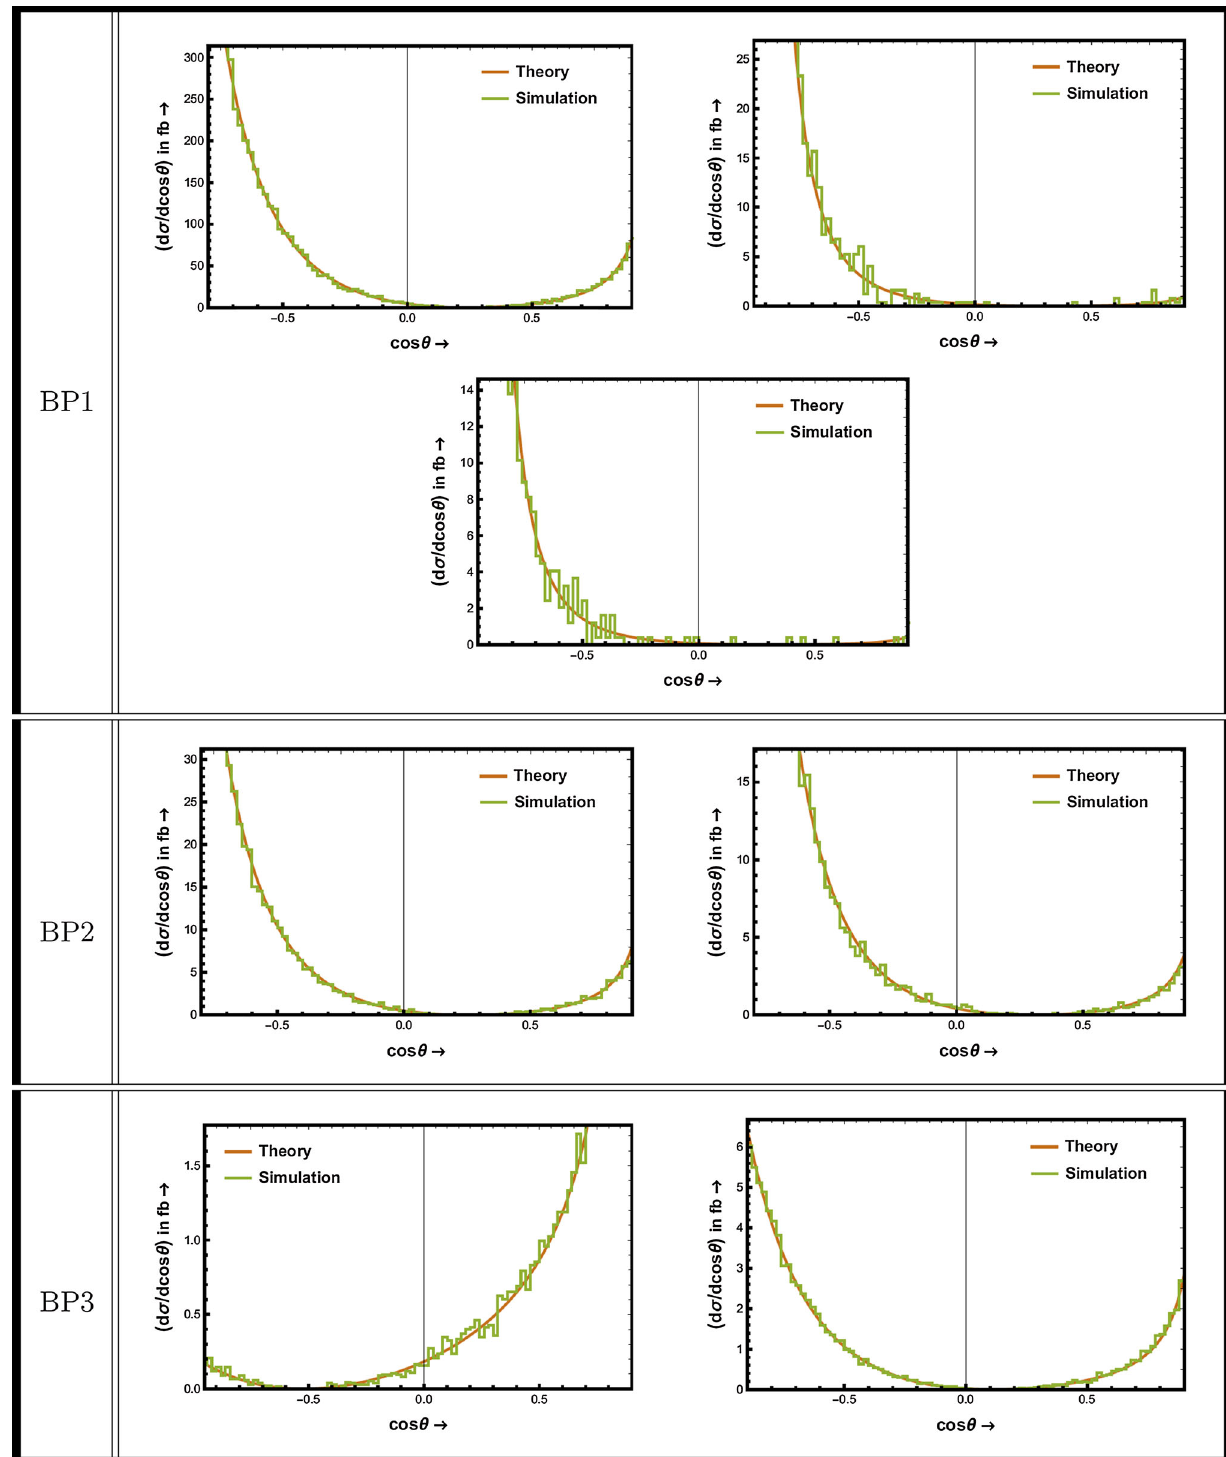
/ 3 ) c at various center of momentum energies for different benchmark points, arranged in Fig. 10 Angular distribution for the production of ( U + 2 1 μ the order of Table 10. The brown (smooth) and green (jagged) lines indicate the theoretical expectations and the PYTHIA simulated